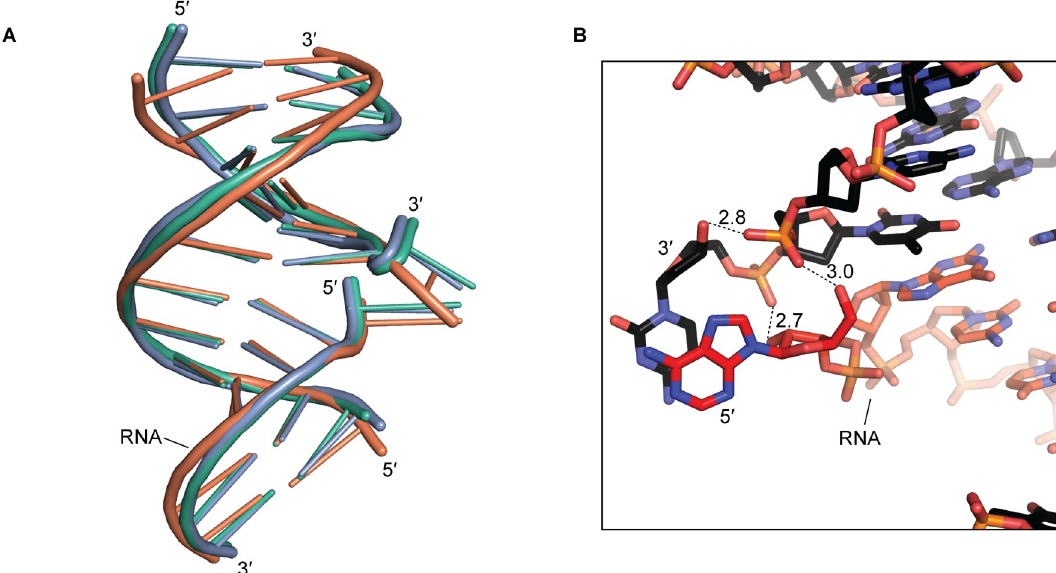
Fig 2. Molecule-to-molecule similarity and hydrogen bonding at the flapped nucleotides. (A) All-atom alignment of the three molecules in the asymmetric unit. Green, Molecule 1; blue, Molecule 2; orange, Molecule 3. Molecules 2 and 3 were aligned to Molecule 1 in this depiction. (B) Hydrogen bonding at the flapped nucleotides of Molecule 1. Dotted lines indicate hydrogen bonds, and adjacent numbers indicate interatomic distance in Å . Black, DNA; red, RNA. This hydrogen bonding pattern is also observed in Molecule 2 but not in Molecule